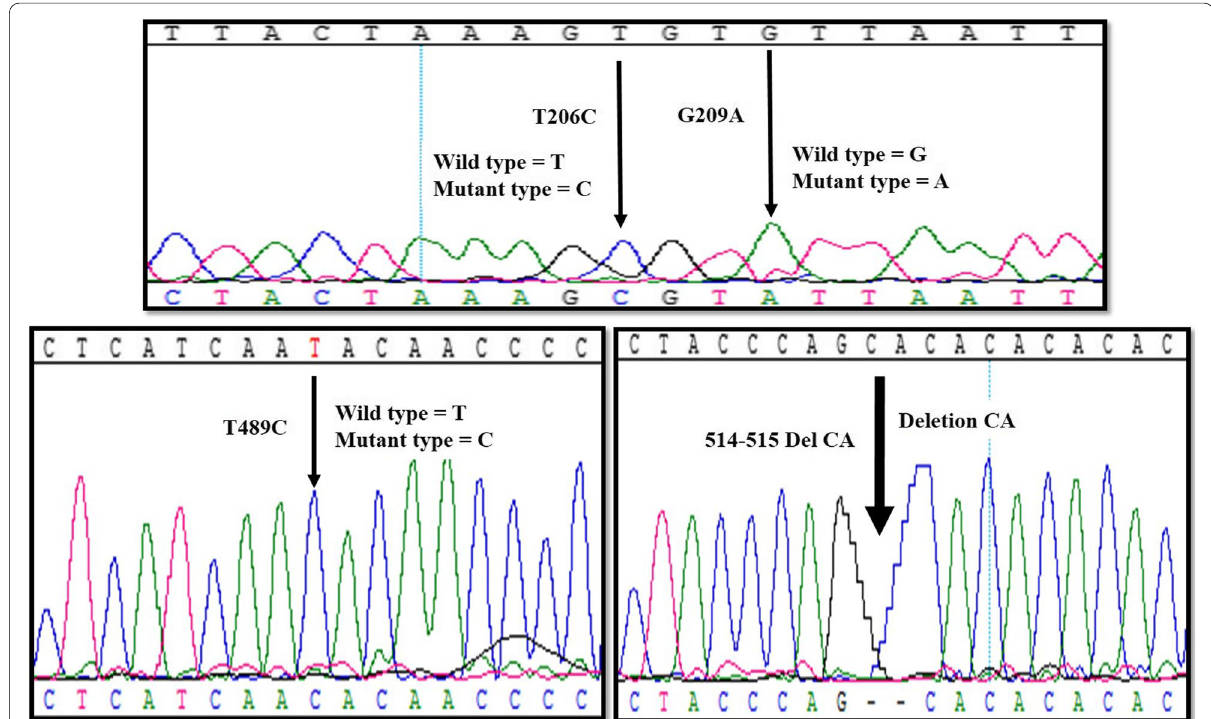
Fig. 4 Chromatogram showing synonymous variation in D-loop region at 206, 209, 489, and 513–514 base position